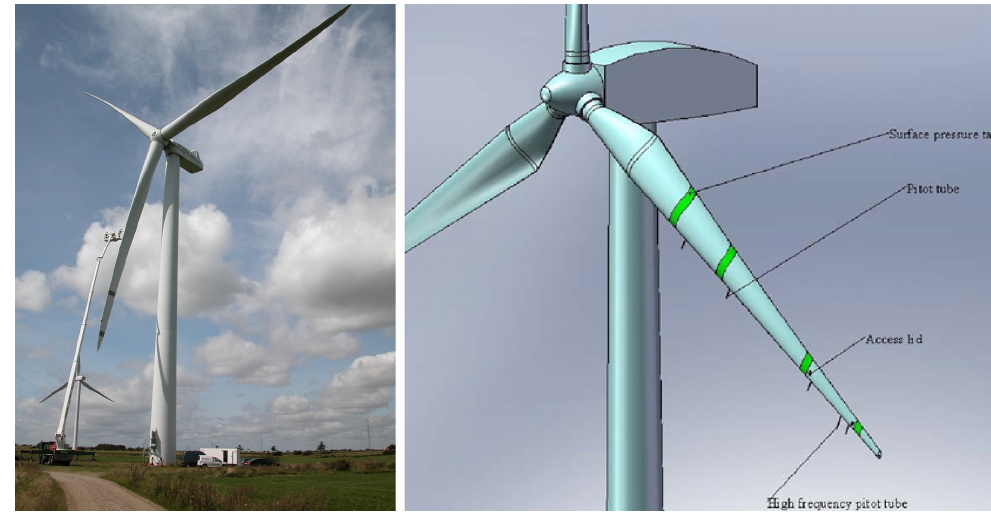
Figure 1. DanAero turbine and instrumentation (Bak et al., 2010). Table 1. High-level summary of participant codes and